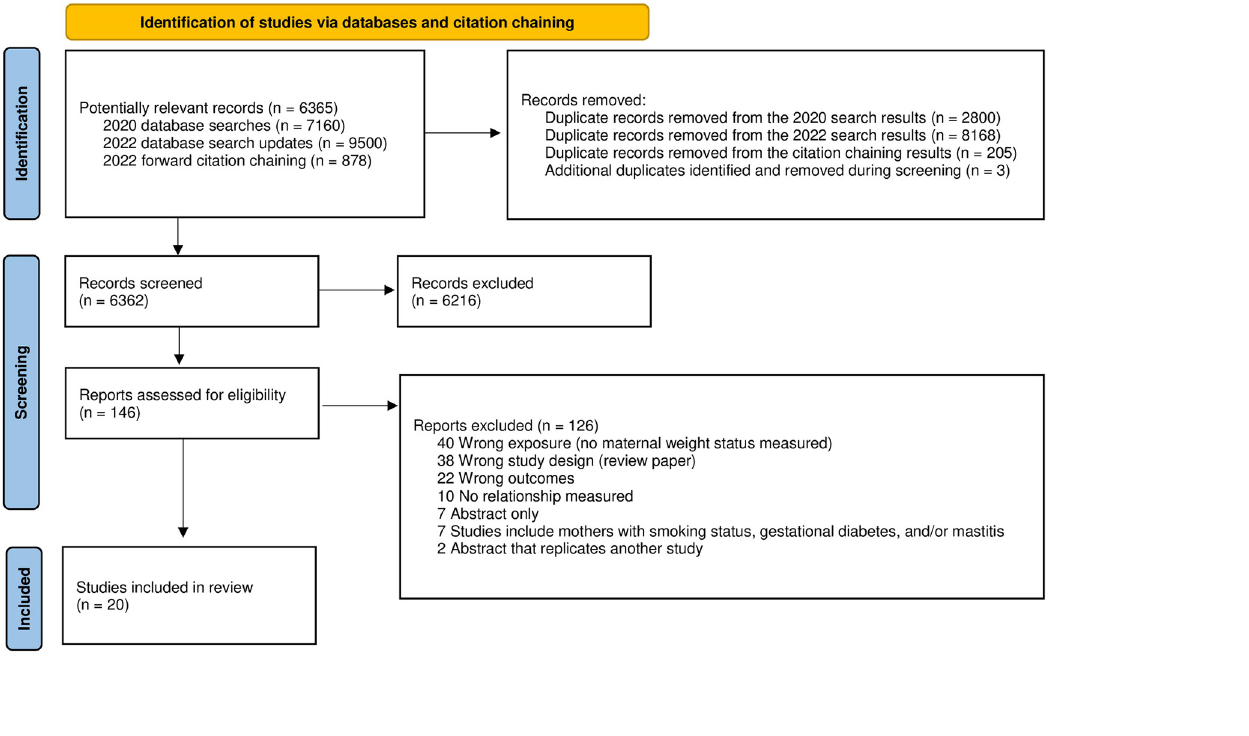
Fig 1. PRISMA 2020 flow diagram for new systematic reviews which included searches of databases and other sources.